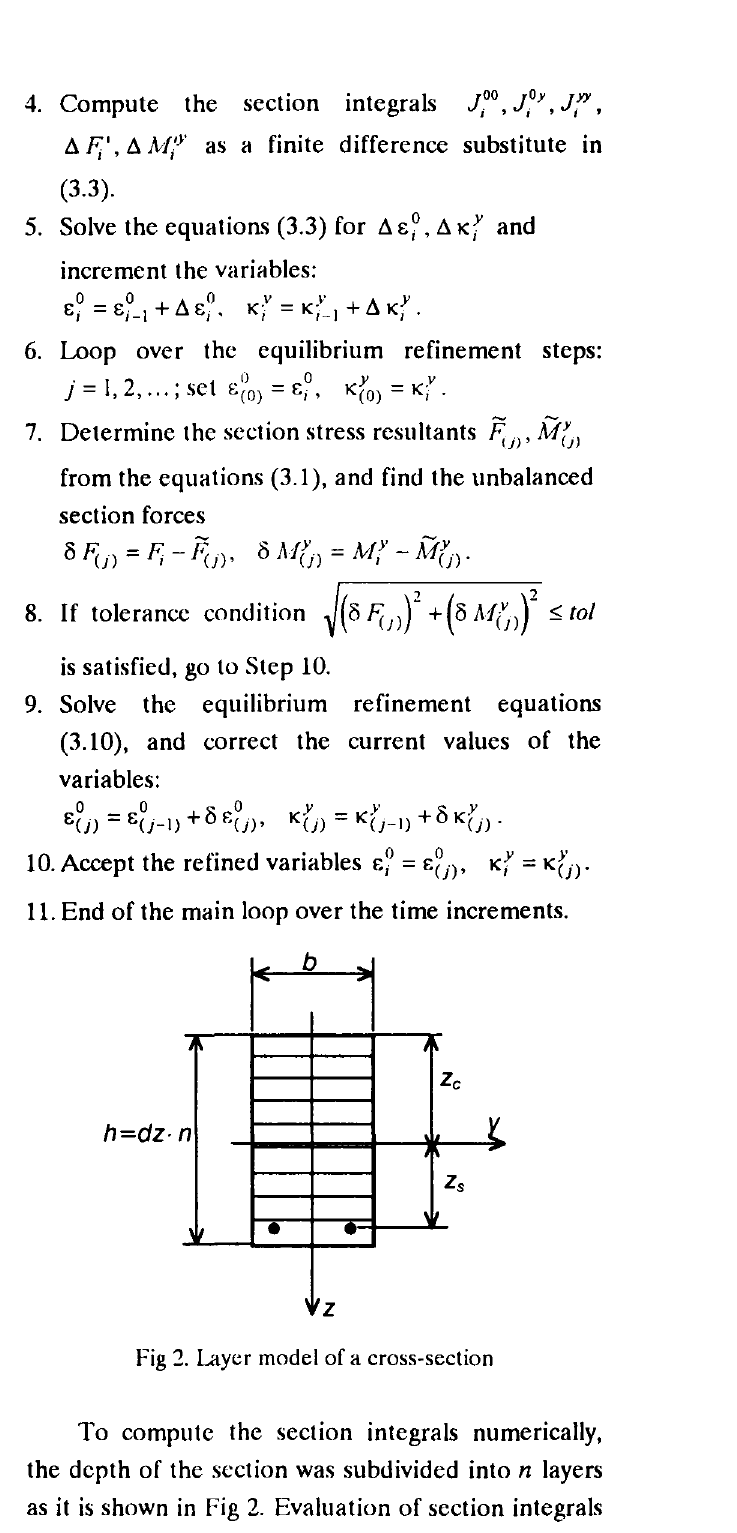
Fig 2. Layer model of a